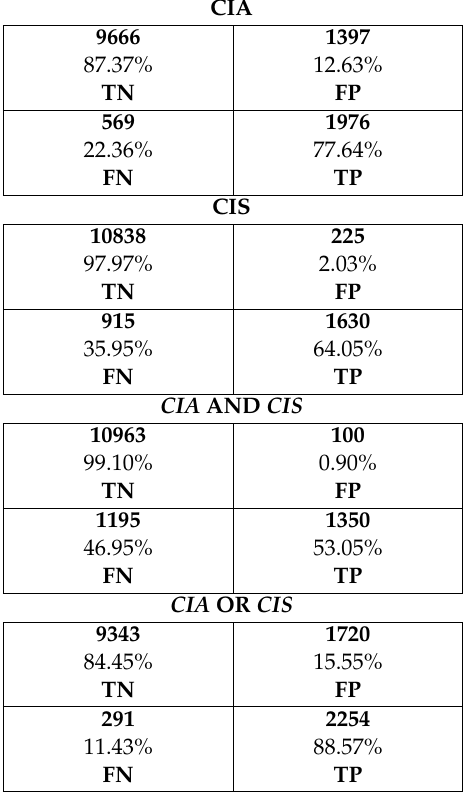
Table 1. Confusion matrix with classification based on CIA, CIS and AND-OR logic